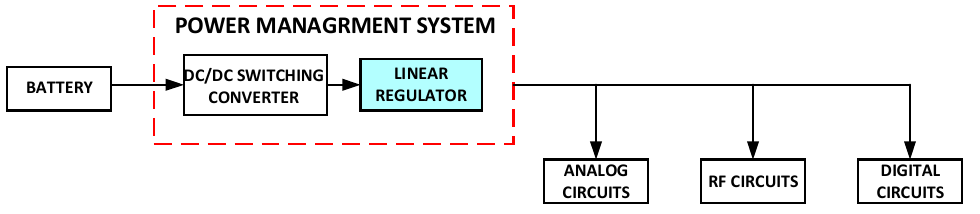
Figure 1. Voltage Regulator in a Power Management